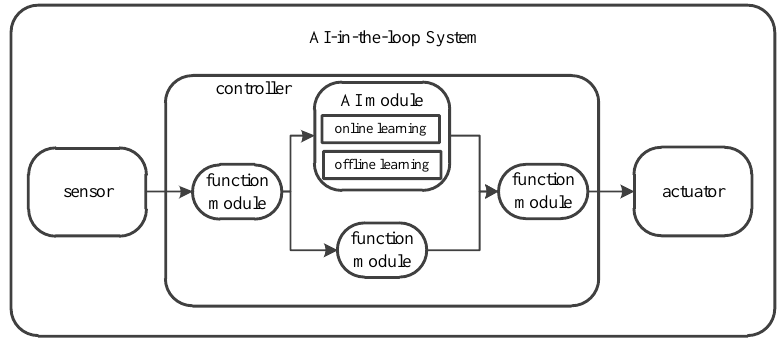
Figure 1. Architecture of the AI-in-the-loop